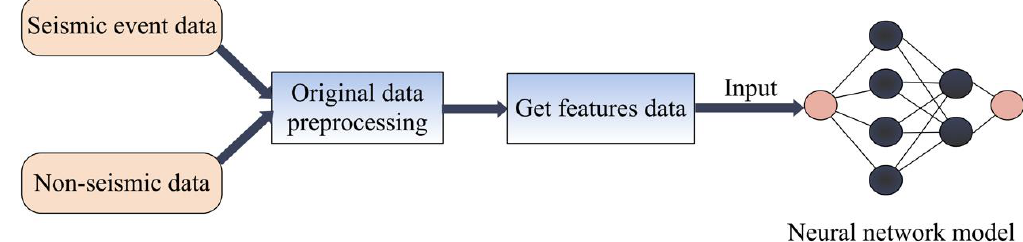
Figure 3. The diagram of data preprocessing.